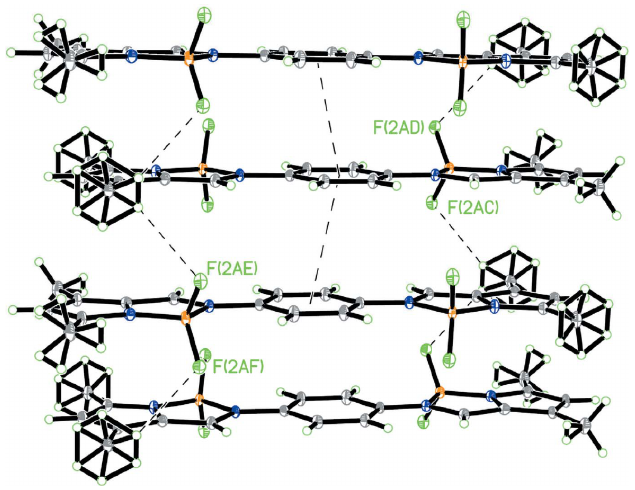
Figure 2 Part of the pillar structure showing molecules linked by C—H (cid:2)(cid:2)(cid:2) F i